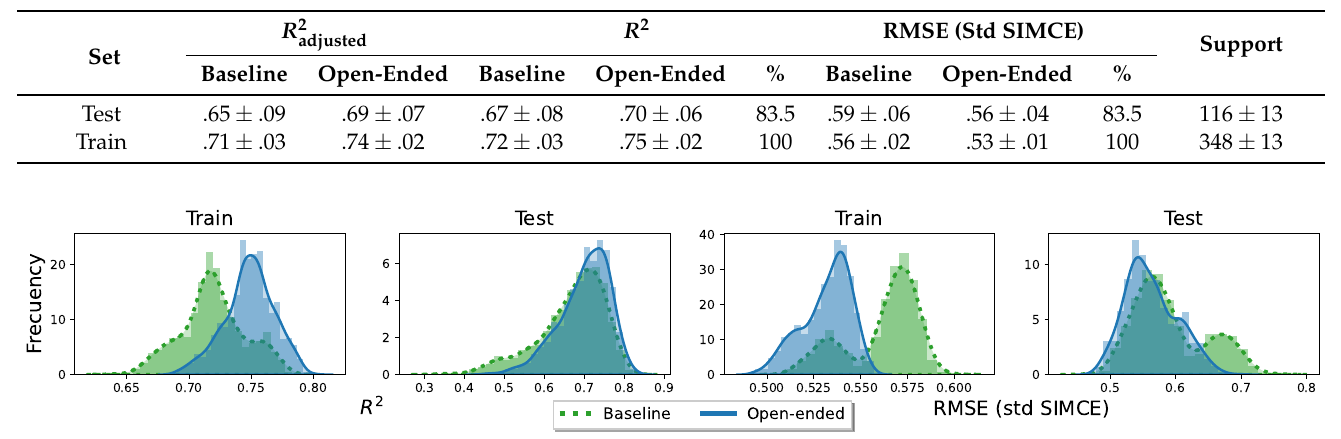
Table 5. Summary of R 2 and RMSE metrics for each model in training and test sets. These are obtained from 250 four-fold cross-validations. RMSE is divided by SIMCE standard deviation (47.80 reported in Ulloa Miranda 2021). The percentage symbol (%) corresponds to the proportion of times when the Open-ended model is better than the baseline model, with R 2 and RMSE resp. Support corresponds to the size of the set used for train or test, resp.